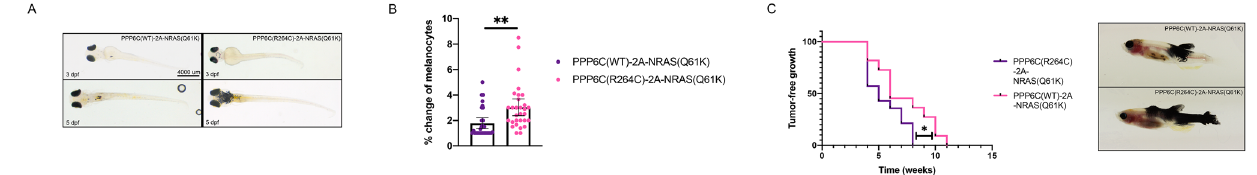
Figure 5. The recurrent PPP6C (R264C) mutation confers a gain of function proliferation phenotype in melanoma. ( A ) Representative images of fish injected with either PPP6C(WT)-2A-NRAS(Q61K) or PPP6C(R264C)-2A-NRAS(Q61K) at 3- and 5-days post fertilization. ( B ) Quantification of proliferation as measured by the change in number of melanocytes from 72 to 120 h post fertilization, N = 15 fish (Student’s two- tailed t-test). ( C ) Representative melanoma-free survival curve comparing tumors expressing PPP6C(R264C) to PPP6C(WT). One of two independent experiments is shown (log-rank (mantel-cox) test). p -values are indicated as following: * p < 0.05, ** p ≤ 0.01.